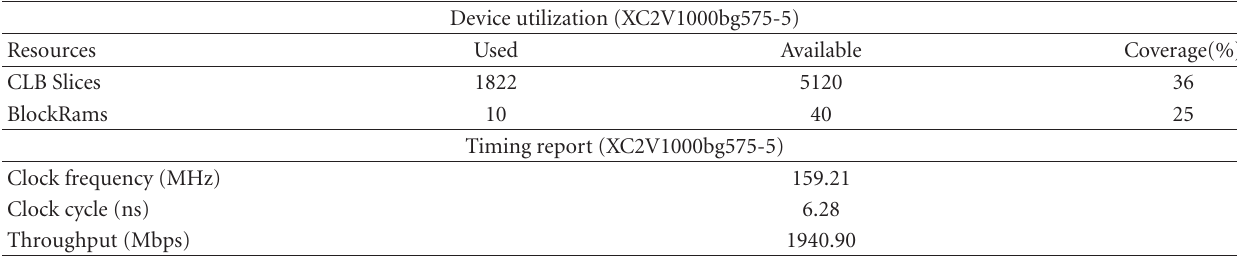
Table 1: Implementation results for CMAC